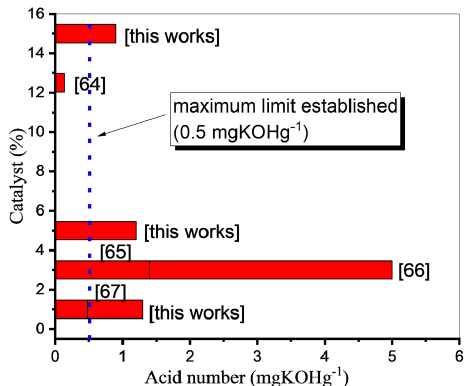
Figure 5. Behavior of the acidity index (IA) in relation to the amount of catalyst (% by mass) in the transesterification of soybean oil.